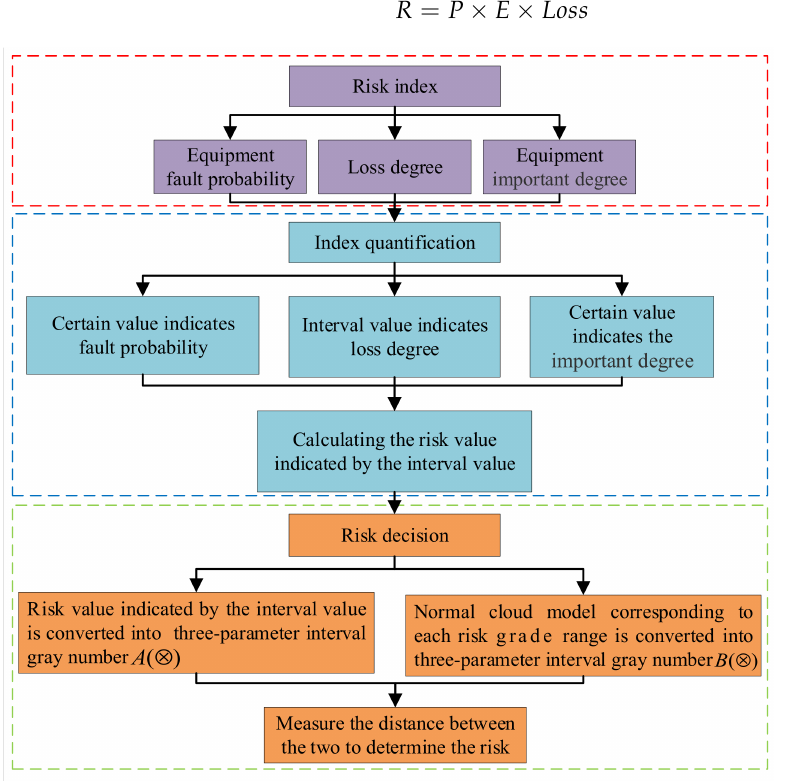
Figure 1. Evaluation index